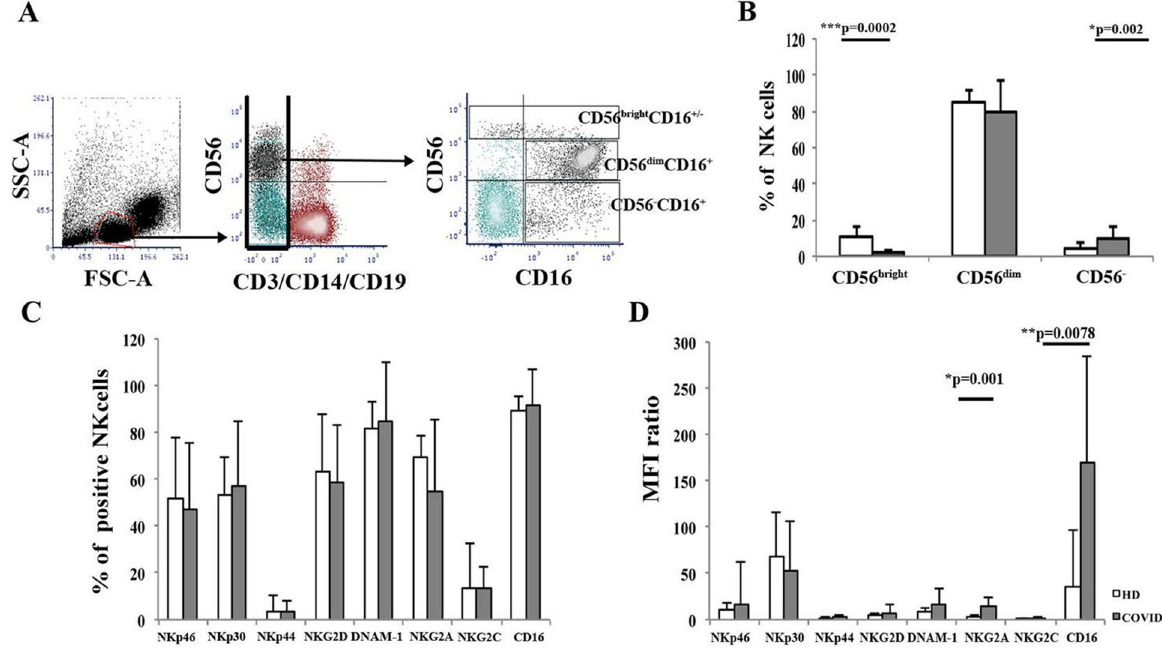
Fig 1. Flow cytometric analysis of peripheral blood NK cell subsets and receptors in COVID-19 patients. Panel A: Flow cytometric gating strategy. Following physical selection (FCS, SSC), CD3-CD19-CD14- cells are gated and further analyzed as NK cells expressing CD16 and CD56. Analysis of the acquisition of 10000 events. Log scale. Panel B: Analysis of peripheral blood NK cell subsets defined by CD16 and CD56 expression in COVID-19 patients (#28, grey columns) and HD (#18, white columns). CD56 bright CD16+/- cells are indicated as CD56 bright , CD56 dim CD16 + NK cells are indicated as CD56 dim ; CD56-CD16+ NK cells are indicated as CD56 - . Histograms show mean ± SD. Cells are gated on CD3-CD19-CD14- cells. Significance by Mann-Whitney U-test analysis is indicated. The ratio between CD56 bright CD16+/- and CD56 dim CD16 + cells is indicated as CD56 bright /CD56 dim . Open histograms: HD. Greyed histogram: COVID-19. Panel C: Analysis of PB NK cell receptor expression. Histograms indicate the proportion of NK cells expressing each surface molecule. Cells are gated on CD3-CD19-CD14- cells. Significance by Mann-Whitney U-test analysis is indicated. Open histograms: HD. Greyed histogram: COVID-19. Panel D: Molecule density expression of NK cell molecules on PB NK cells. Molecule density is expressed as the MFI ratio. Histograms show mean ± SD. Mann-Whitney U- test analysis is